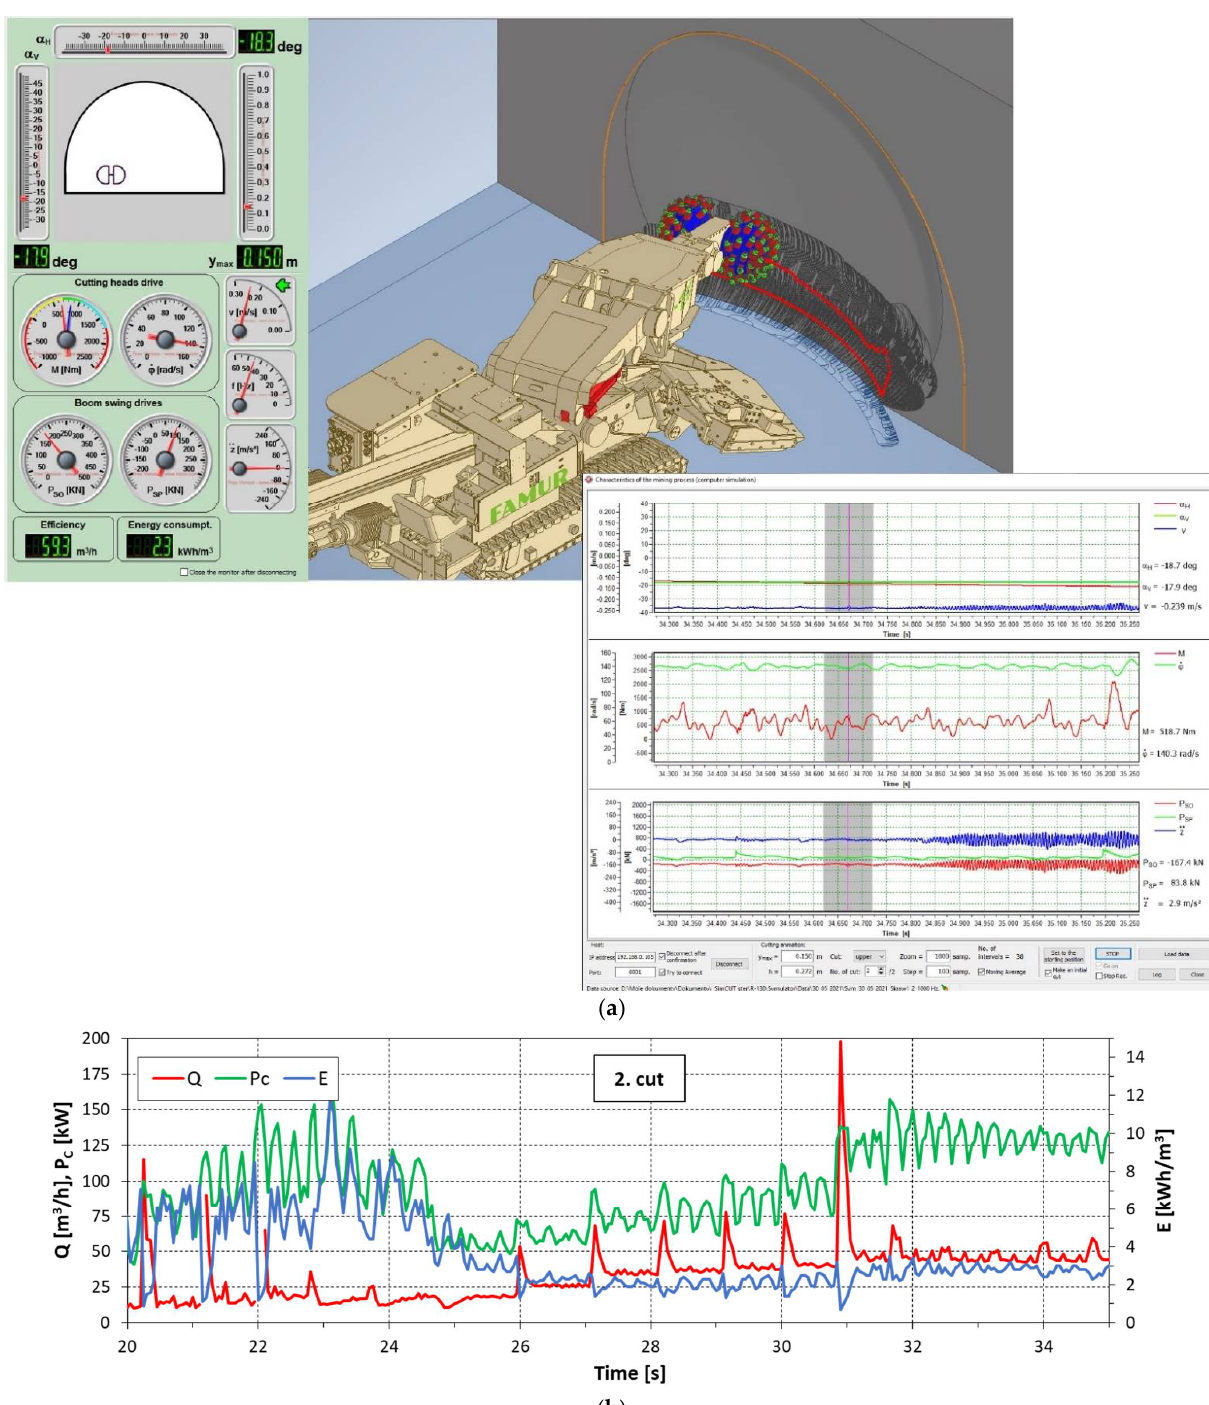
Figure 16. RH-Sim_ research simulator in the simulated mining mode: ( a ) view of the Main Program window and the Data Processing Module, ( b ) a fragment of the course of efficiency, power, and energy consumption of mining.